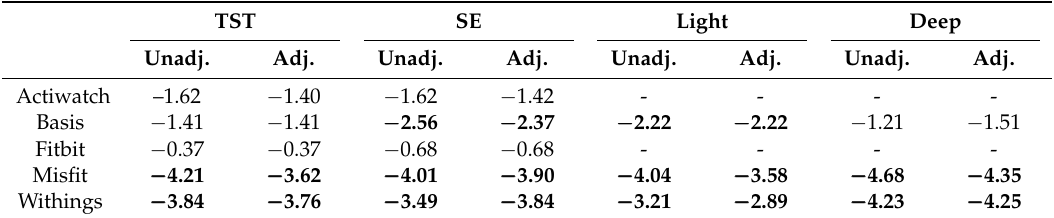
Table 4. Z-values of Wilcoxon Signed Rank Test. Bold indicates a significant difference between devices (p < 0.05).